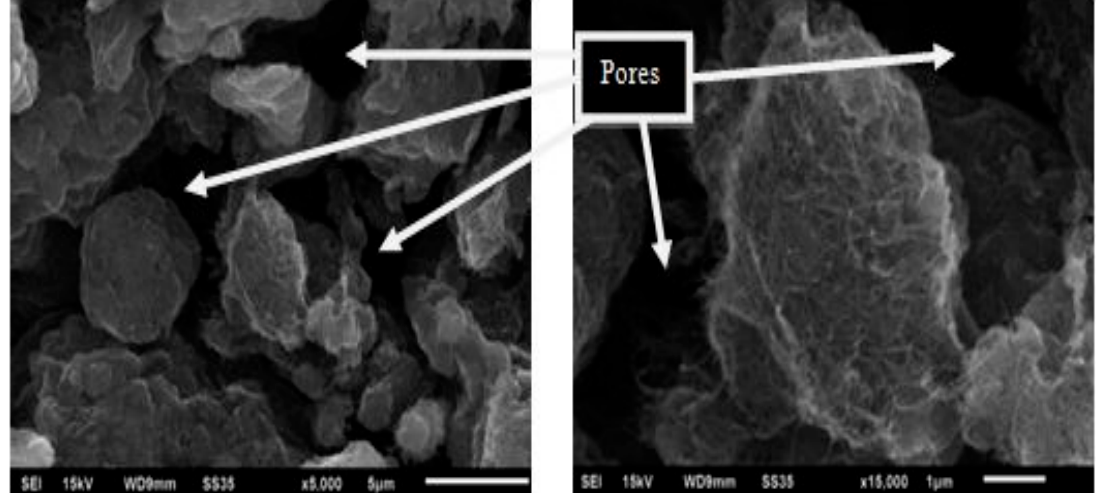
Figure 4. Electron Microscopy (SEM) images of the Multi-walled Carbon Nanotube (MWCNT) electrode.